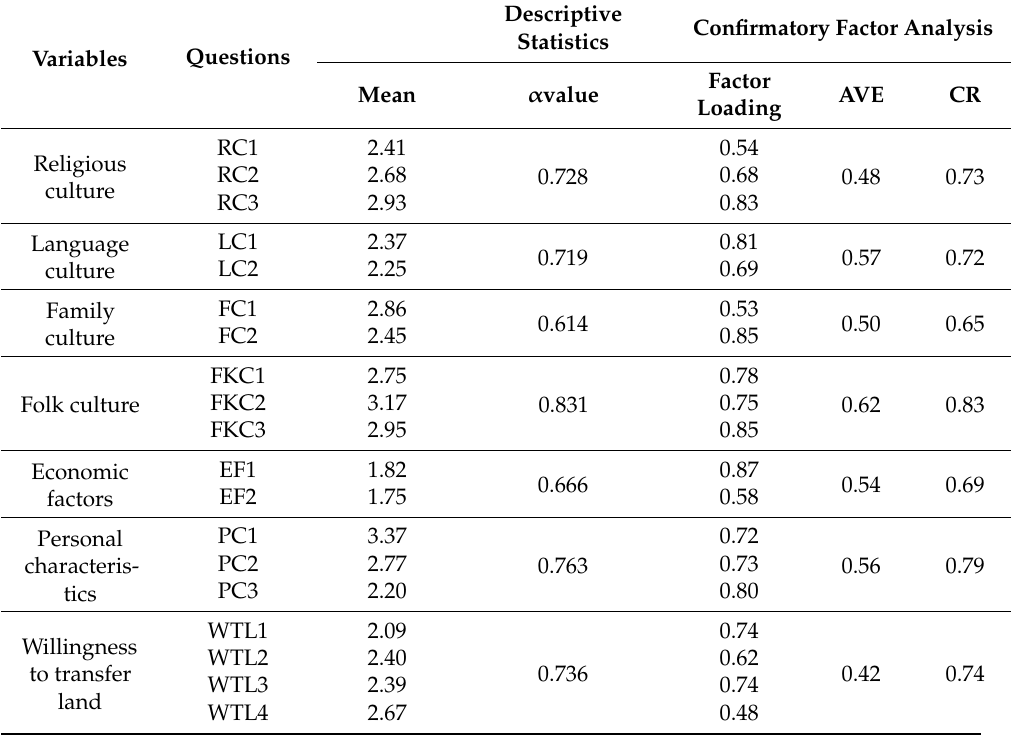
Table 4. Validity and